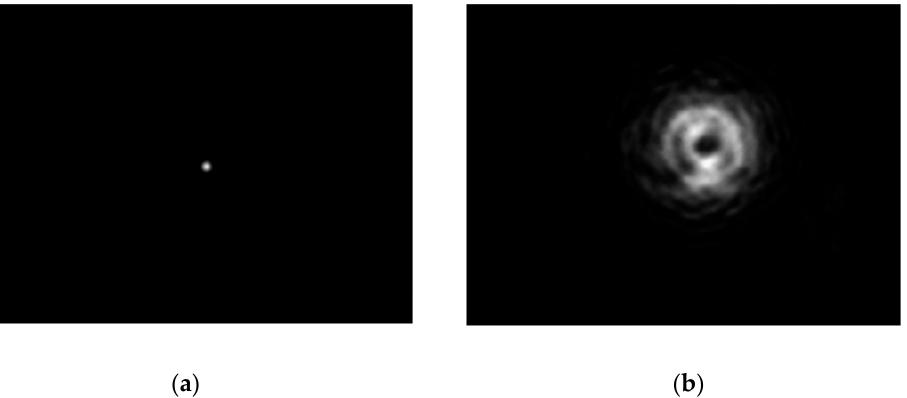
Figure 4. The imaging light spot: ( a ) The imaging light spot reflected by a plane; ( b ) the imaging light spot reflected by a rotating